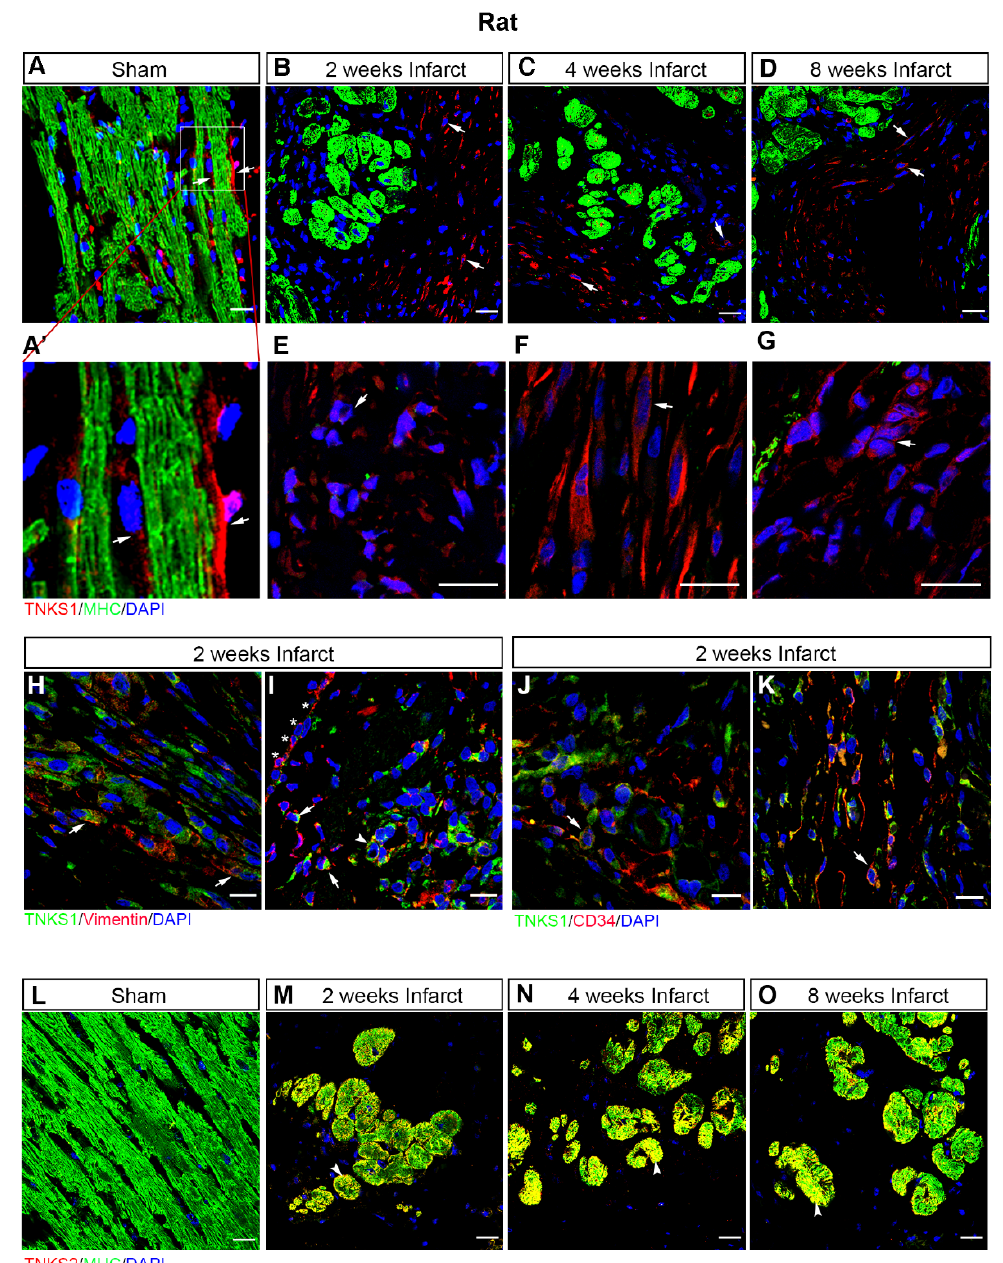
Figure 4. Ischemic injury stimulates TNKS1 in non-cardiomyocytes and TNKS2 in cardiomyocytes in the infarct area in rat hearts. ( A – D ) Representative immunohistochemical staining of TNKS1 (in red) and MHC (in green) in ventricular sections from sham-operated and MI rat hearts at 2, 4, and 8 weeks post-MI. The TNKS1-positive signal is visualized in the vasculature (arrow) in sham-operated hearts ( A , A’ ) and in non-cardiomyocytes (examples indicated by arrows) in the infarct area at the examined time points ( B – D ). ( A’ ) Inset : magnified image of TNKS1-positive cells within the vasculature. ( E – G ) Representative images of immunohistochemical staining showing the TNKS1-positive signal in granulocytes-like cells ( E ), fibroblasts ( F ), and endothelium-like cells ( G ) indicated by the arrow in the infarct area. ( H , I ) Representative immunohistochemical staining of TNKS1 (in green) and vimentin (in red) showing accumulation of TNKS1 in vimentin-positive fibroblasts (arrow in H ), EMT cells (arrow in I ), and vascular endothelial cells (arrowhead in I ) in the infarct area at 2 weeks post-MI. Stars (* in I) indicate the epicardium. ( J , K ) Representative immunohistochemical staining of TNKS1 (in green) and CD34 (in red) showing accumulation of TNKS1 in CD34-positive (arrow) vascular endothelial cells ( J ) and circulating cells ( K ) in the infarct area at 2 weeks post-MI. ( L – O ) Representative immunohistochemical staining of TNKS2 (in red) and MHC (in green) in